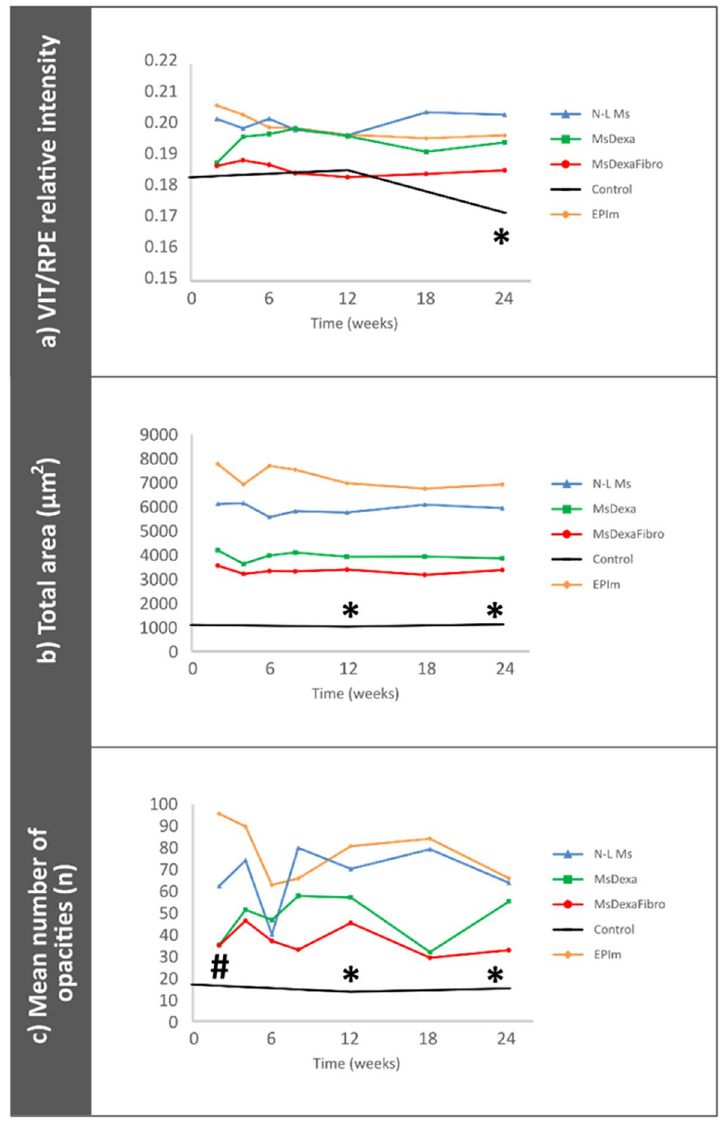
immune response; ( c ): mean number of opacities to quantify immune cells. N-L Ms cohort with non-loaded microspheres; MsDexa cohort with microspheres loaded with dexamethasone; MsDexaFibro cohort with microspheres loaded with dexamethasone and fibronectin; EPIm cohort with sclerosis of the episcleral veins. *: statistical significance ( p < 0.05) between glaucoma models and healthy controls (ANOVA); #: statistical significance between the episcleral vein sclerosis model and each microsphere model by Scheffé test. Note that at later times, differences were found between EPIm and some of the microsphere models, (data not